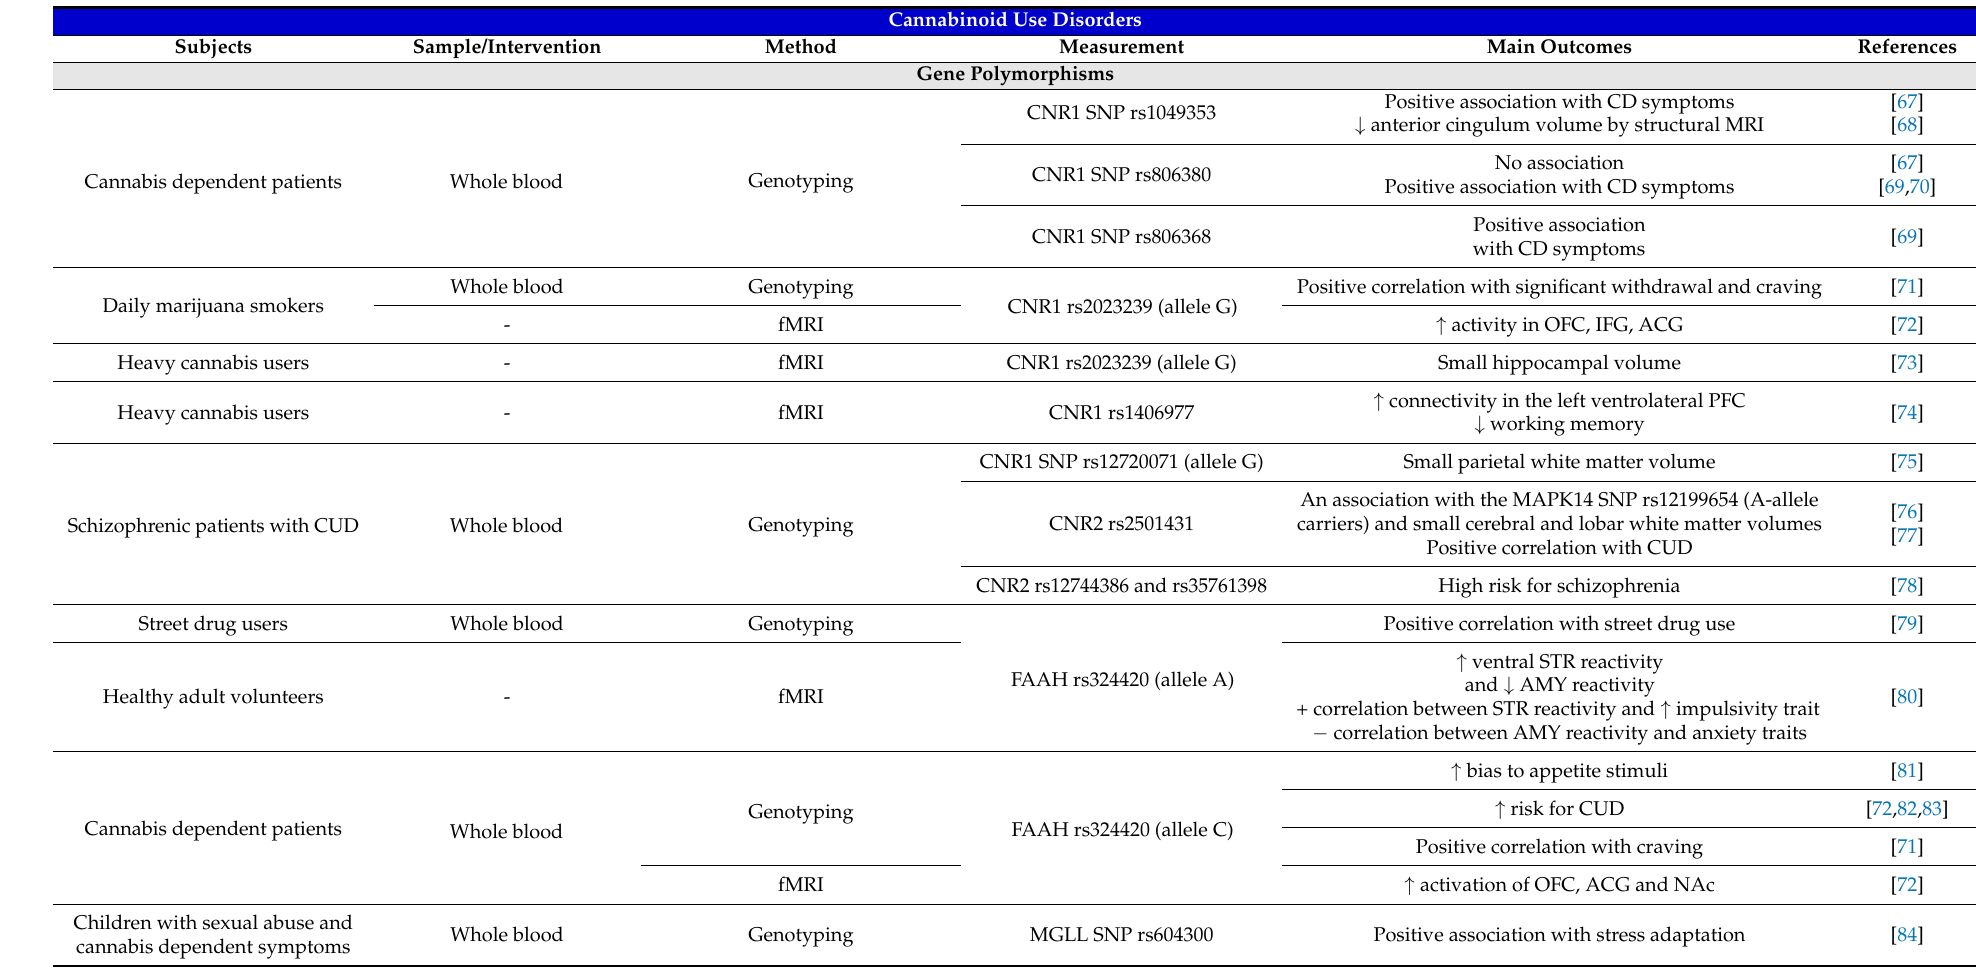
Table 2. Main findings from human and animal studies aimed to identify alterations of ECS components in cannabis-related